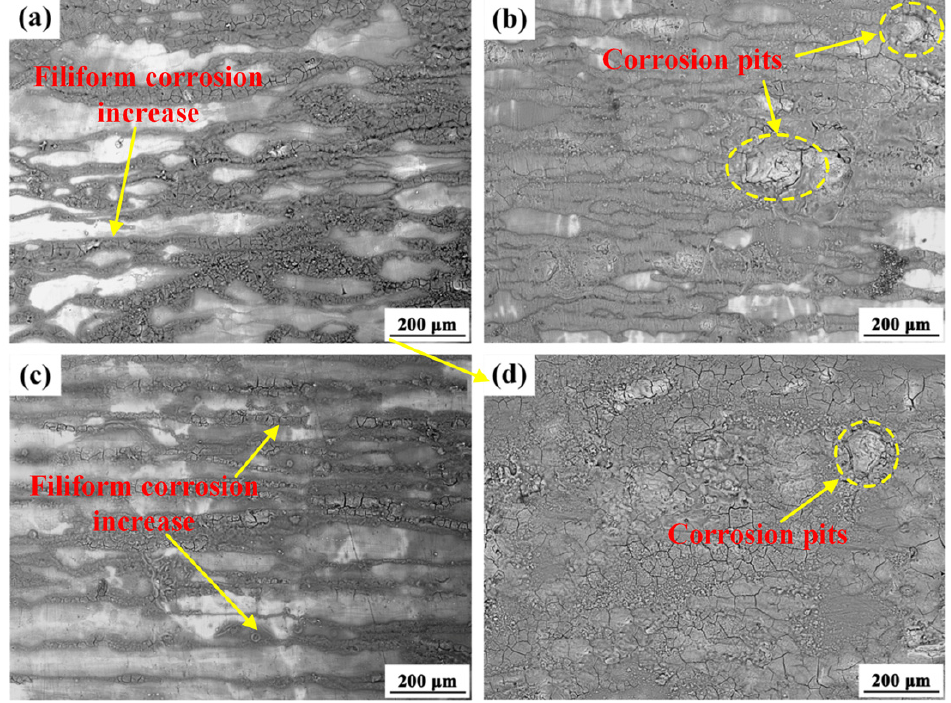
Figure 11. Surface corrosion morphologies of ( a ) ZK60E, ( b ) ZK60EF-250, ( c ) ZK60EF-300, and ( d ) ZK60EF-450 in continuous salt spray environment for 24 h.